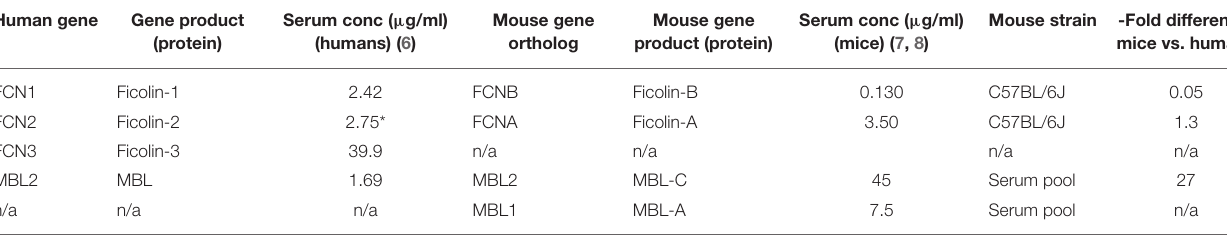
TABLE 1 | Comparison of serum concentrations of MBL and ficolin variants in humans and mice. Mouse gene Mouse gene Serum conc ( µ g/ml) Mouse strain -Fold difference: Human gene Gene product Serum conc ( µ g/ml) ortholog product (protein) (mice) (7, 8) mice vs. (protein) (humans) (6)